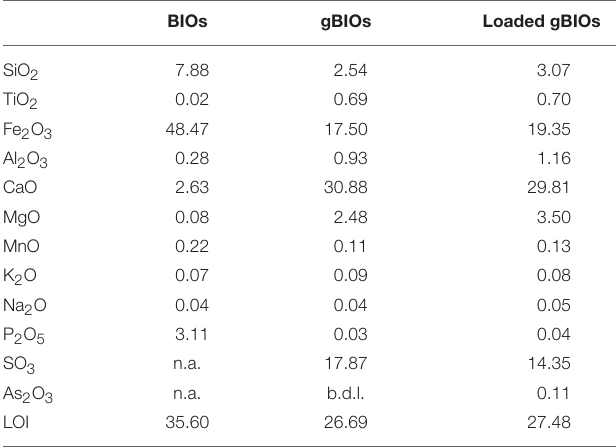
TABLE 2 | Chemical composition (wt. %) of natural and gBIOs, prior and after adsorption experiment. BIOs